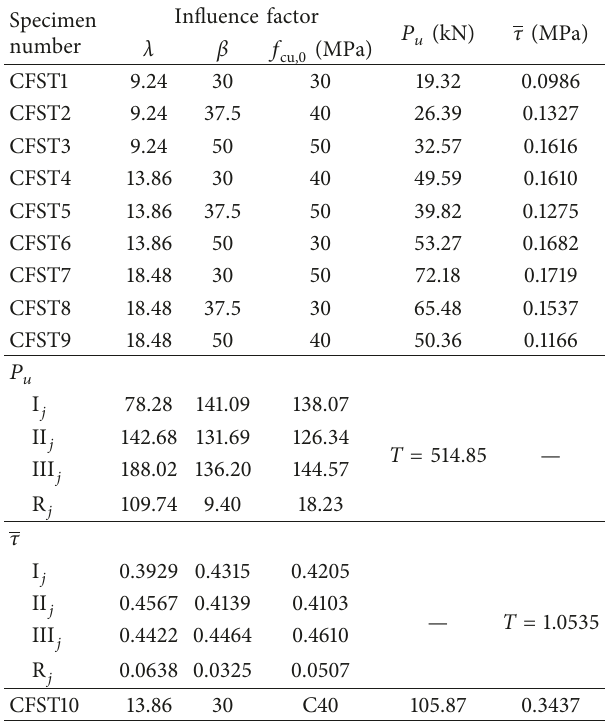
Table 4: Experimental results and corresponding range analysis.